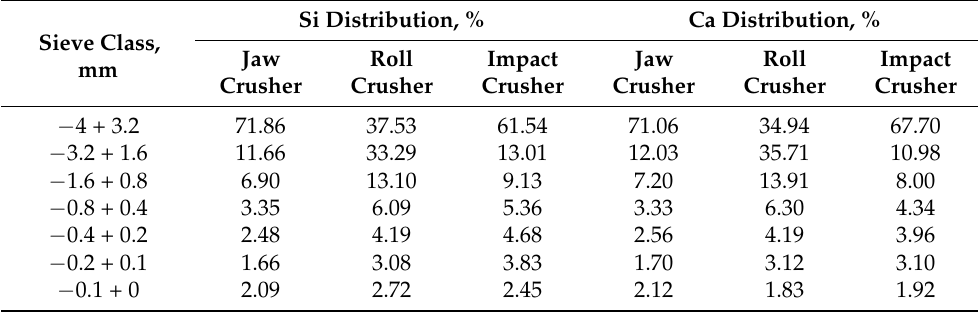
Table 8. Copper and nickel distribution in sieve classes for CNO for different types of crushers. Cu Distribution, % Ni Distribution, % Sieve Class, Jaw Roll Impact Jaw Roll Impact mm Crusher Crusher Crusher Crusher Crusher Crusher − 4 + 3.2